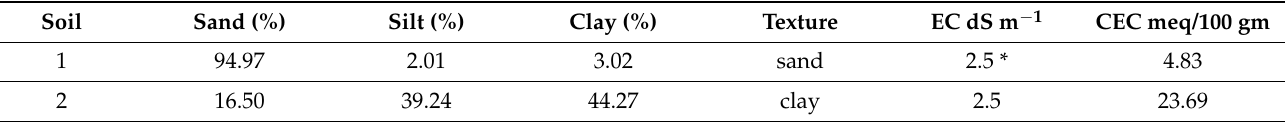
Table 3. Mechanical analysis of specific test soils.